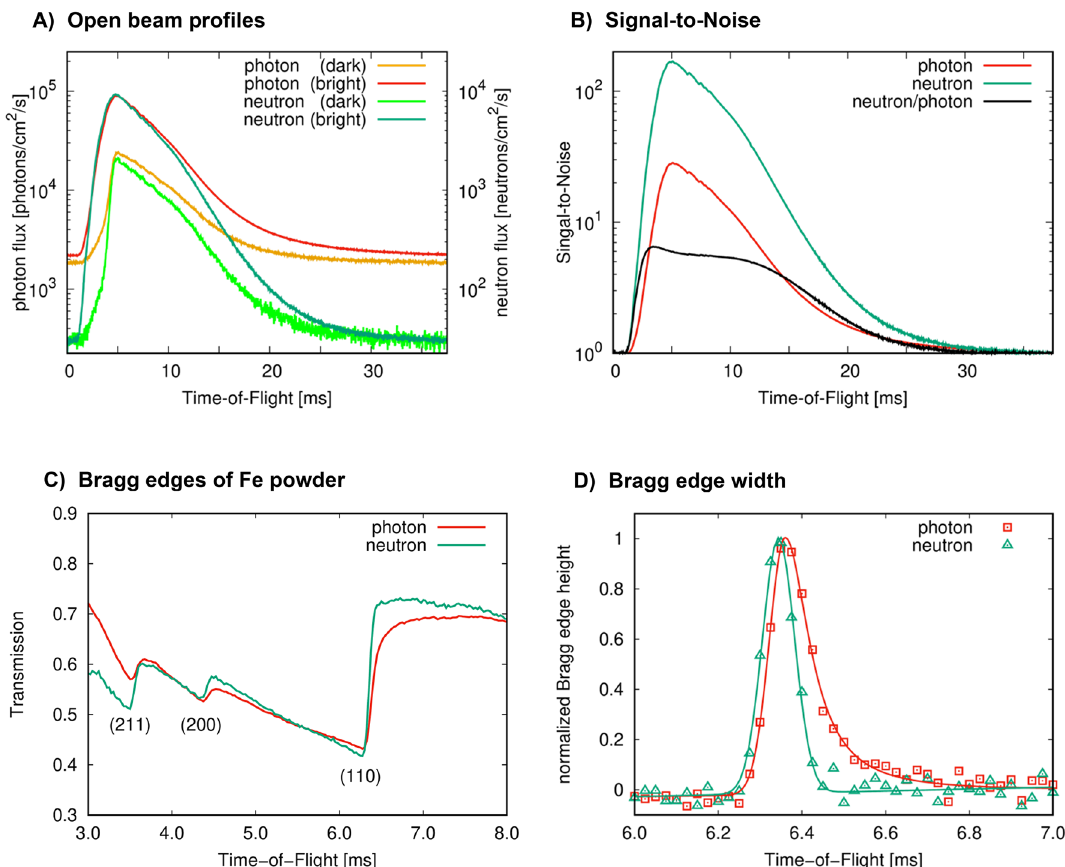
Figure 2. Detected photon and neutron flux in event-mode in ( A ), with photon intensities plotted on the left y-axis and neutron intensities plotted on the right y-axis. In the title, “dark” corresponds to regions of lower intensities and “bright” to regions of higher intensities of the incident beam of selected active detector areas. Signal-to-noise in photon and neutron event-modes averaged over the entire FoV in ( B ). Bragg edge profiles of 2 cm of iron powder measured in photon and neutron event-mode in ( C ). Derivative of the Bragg edge profiles with the peak height normalized to unity for comparison of the time response in photon and neutron event- mode in ( D